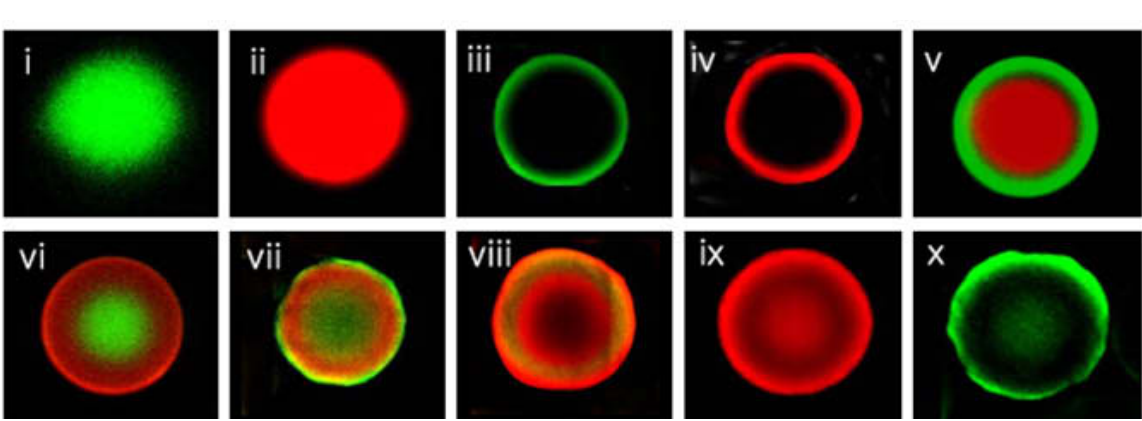
Figure 2. Fluorescence images of layer-by-layer fluorescence dye particles (reproduced with permission from reference [35]. Copyright 2010, Elsevier B.V.).